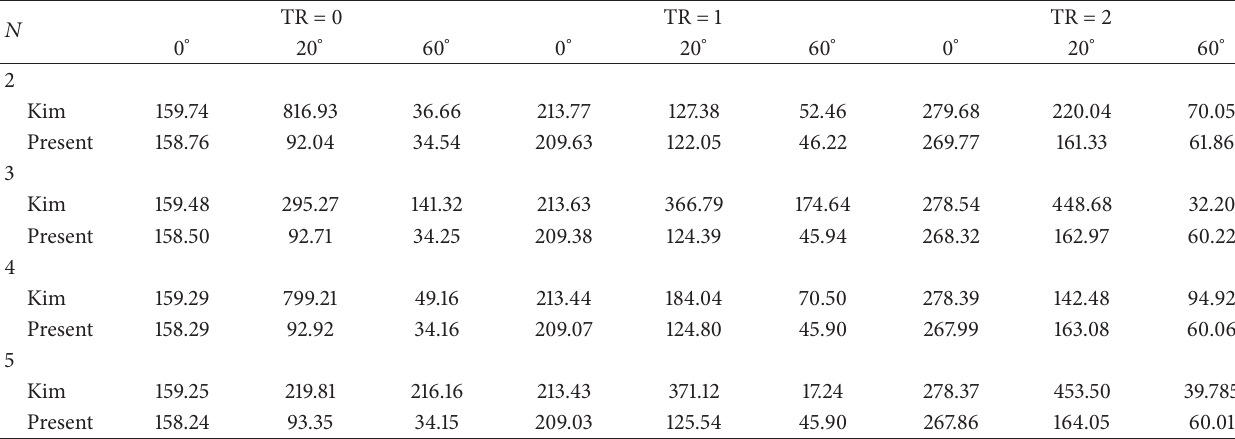
Table 5: Effect of mode number 𝑁 on the first natural frequencies ([ 𝜃 ] 6 , Ω = 0rad/s).